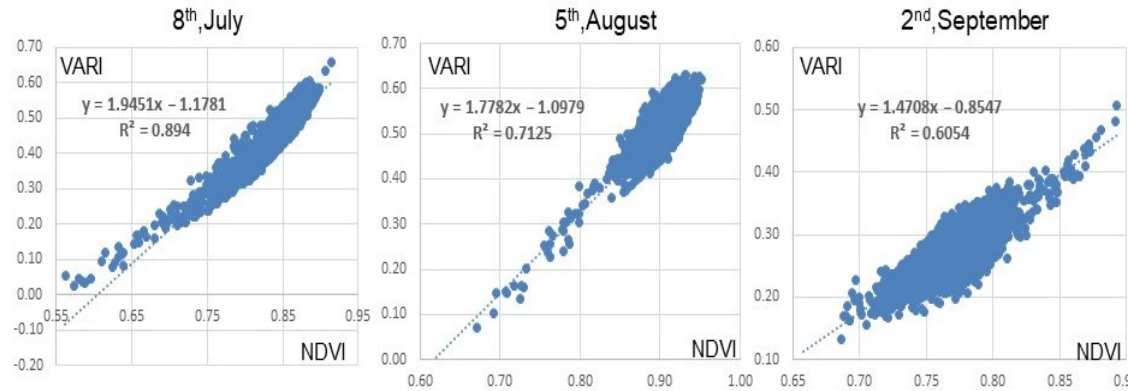
Figure 8. Correlation of temporal NDVI-VARI value of paddy field. (Micasense images).